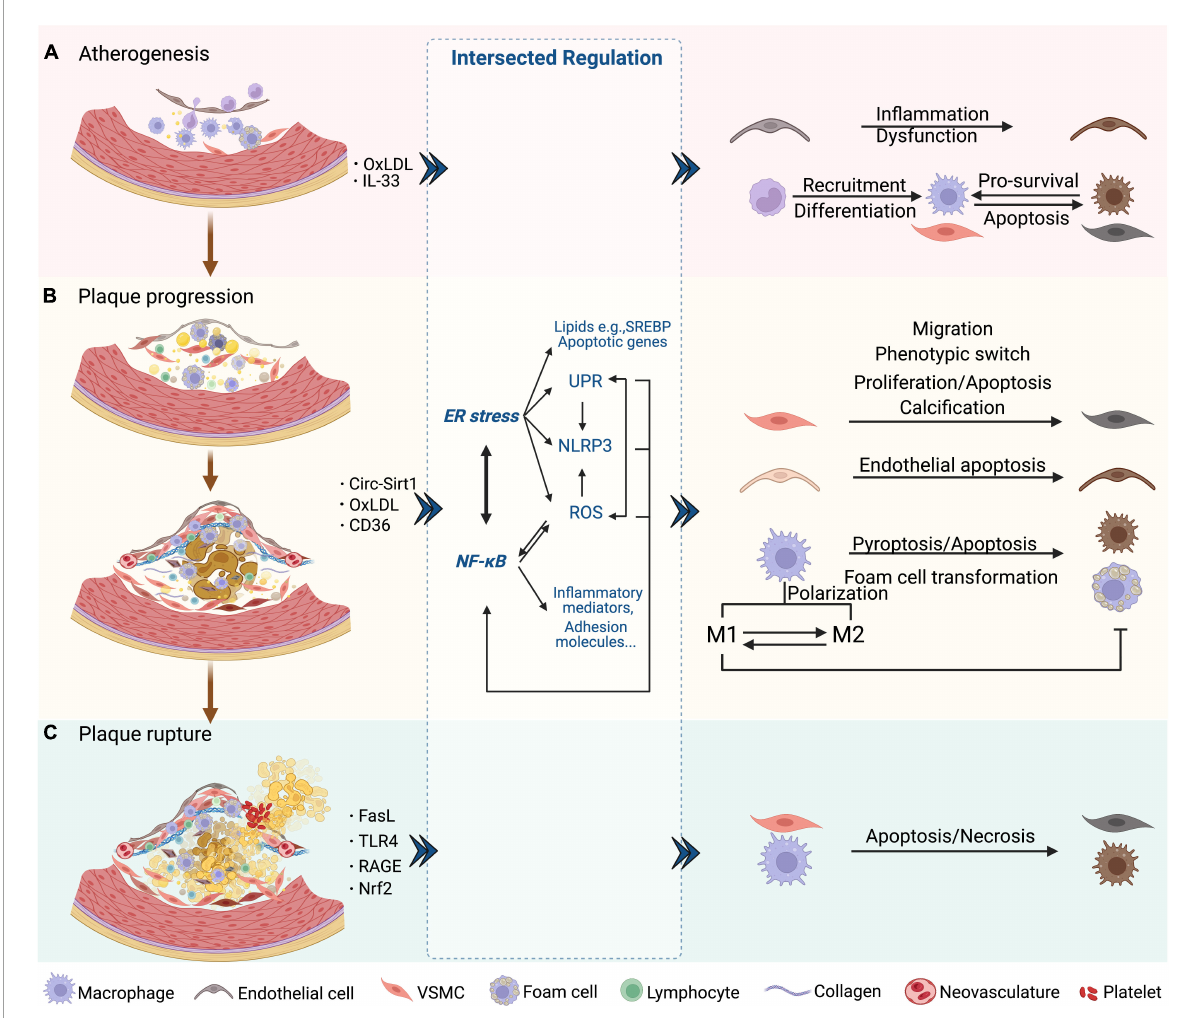
FIGURE2 NF- κ B and ER stress in three phases of AS. (A) Atherogenesis. Endothelial dysfunction as an initial event in atherogenesis is induced by NF- κ B and downstream inflammatory mediators. The SREBP pathway is induced by ER stress and aggravates endothelial dysfunction. SREBP- and NF- κ B-induced NLRP3 inflammasome contributes to atherogenesis. Chemokines induced by NF- κ B attract lymphocytes and trigger endothelial inflammation. NF- κ B also promotes the recruitment and differentiation of monocytes by increasing the levels of adhesion molecules and M-CSF of endothelial cells. After differentiated into macrophages, UPR markers are activated, which protects macrophages from ER stress-induced apoptosis. (B) Plaque progression. This phase is characterized by foam cell formation, VSMC migration and proliferation, ECM accumulation, and NC formation. ROS/NF- κ B regulates the migration and phenotypic switch of VSMCs. Circ-Sirt1 inhibits NF- κ B and thus alleviates the progression of AS. Macrophages uptake oxLDL via CD36 and this triggers the NF- κ B signaling pathways, which promotes the transformation into foam cells. XBP-1 also regulates foam cell formation, endothelial apoptosis and VSMC calcification. Inhibition of ER stress promotes the formation of M1 subtype and subsequent foam cell formation. In macrophages, activated NLRP3 inflammasome causes pyroptosis and apoptosis via caspase. (C) Plaque rupture. This phase is characterized by less SMCs and collagen, and more lipids and macrophages, which could involve NF- κ B-FasL pathway. Macrophages induce plaque rupture by secreting MMPs, which is regulated by TLR4/NF- κ B and RAGE/NF- κ B signaling. Apoptosis of macrophages and VSMCs is induced by the prolonged ER stress, including PERK and IRE-XBP1. CHOP is also a mediator of apoptosis, vascular remodeling and plaque necrosis, whose expression is promoted by UPR signaling. Nrf2, as a synergistic mediator between NF- κ B and ER stress, has an athero-protective role by upregulating some antioxidant enzymes. Additionally, NLRP3 inflammasome-mediated up-regulation of MMPs predisposes plaque to rupture.